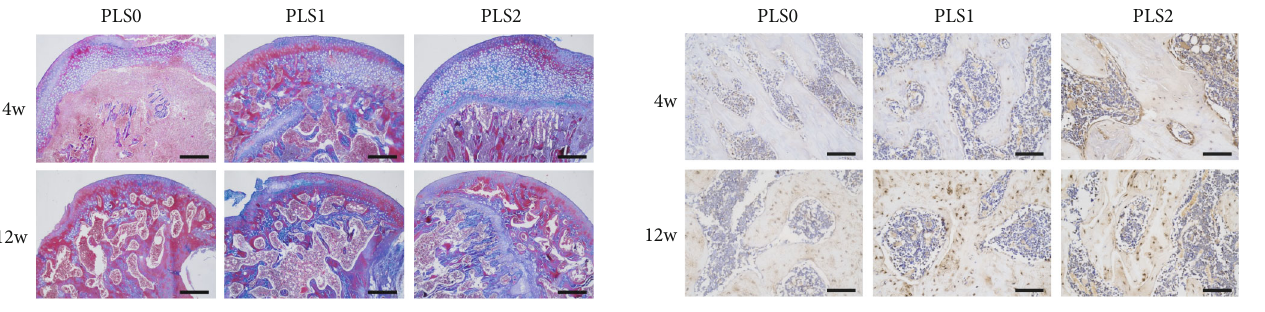
Figure 6: Histopathological type I staining demonstrated the composition of bone tissue (200x).